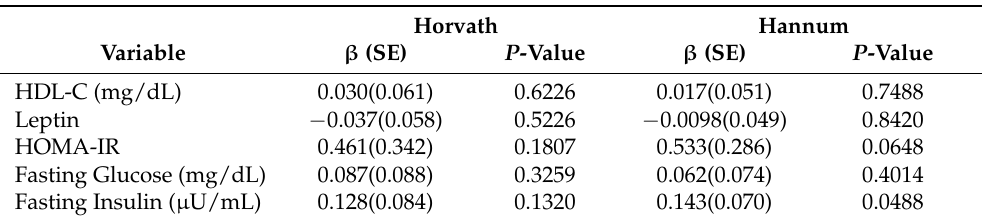
Table 4. Multivariable Linear Regression * of the association between metabolic biomarkers with DNAm age acceleration residual in Offspring (N = 116). Horvath